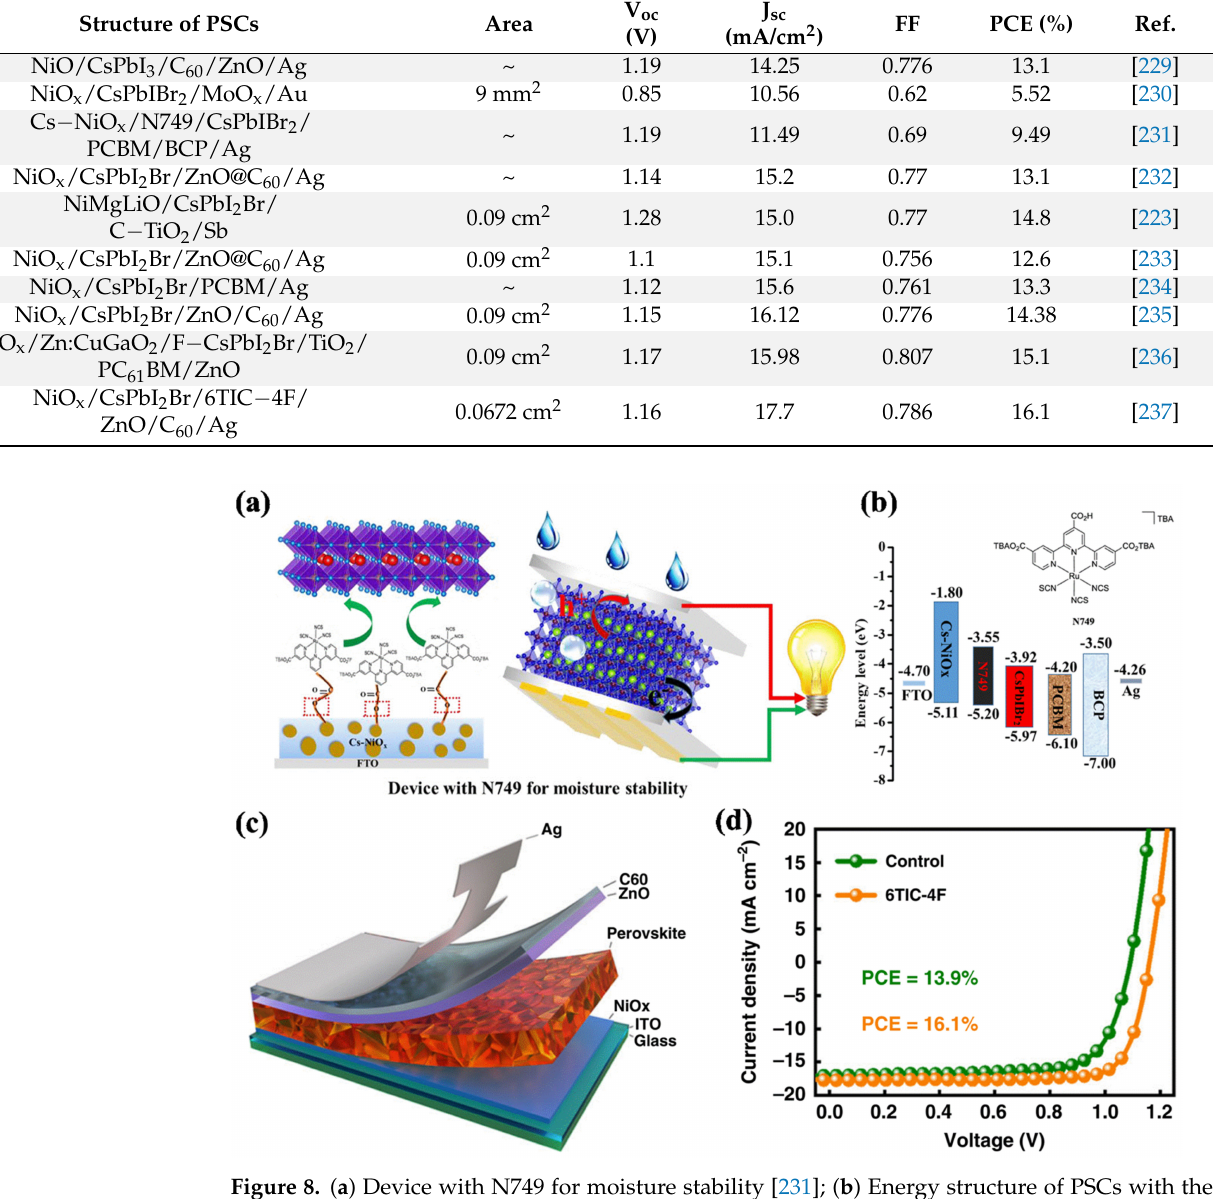
Figure 8. ( a ) Device with N749 for moisture stability [231]; ( b ) Energy structure of PSCs with the construction of Cs − NiO x /N749/CsPbIBr 2 /PCBM/BCP/Ag [231]; ( c ) Device structure of devices with the construction of NiO x /CsPbI x Br 3 − x /ZnO/C 60 /Ag [237]; ( d ) J − V graph of PSCs